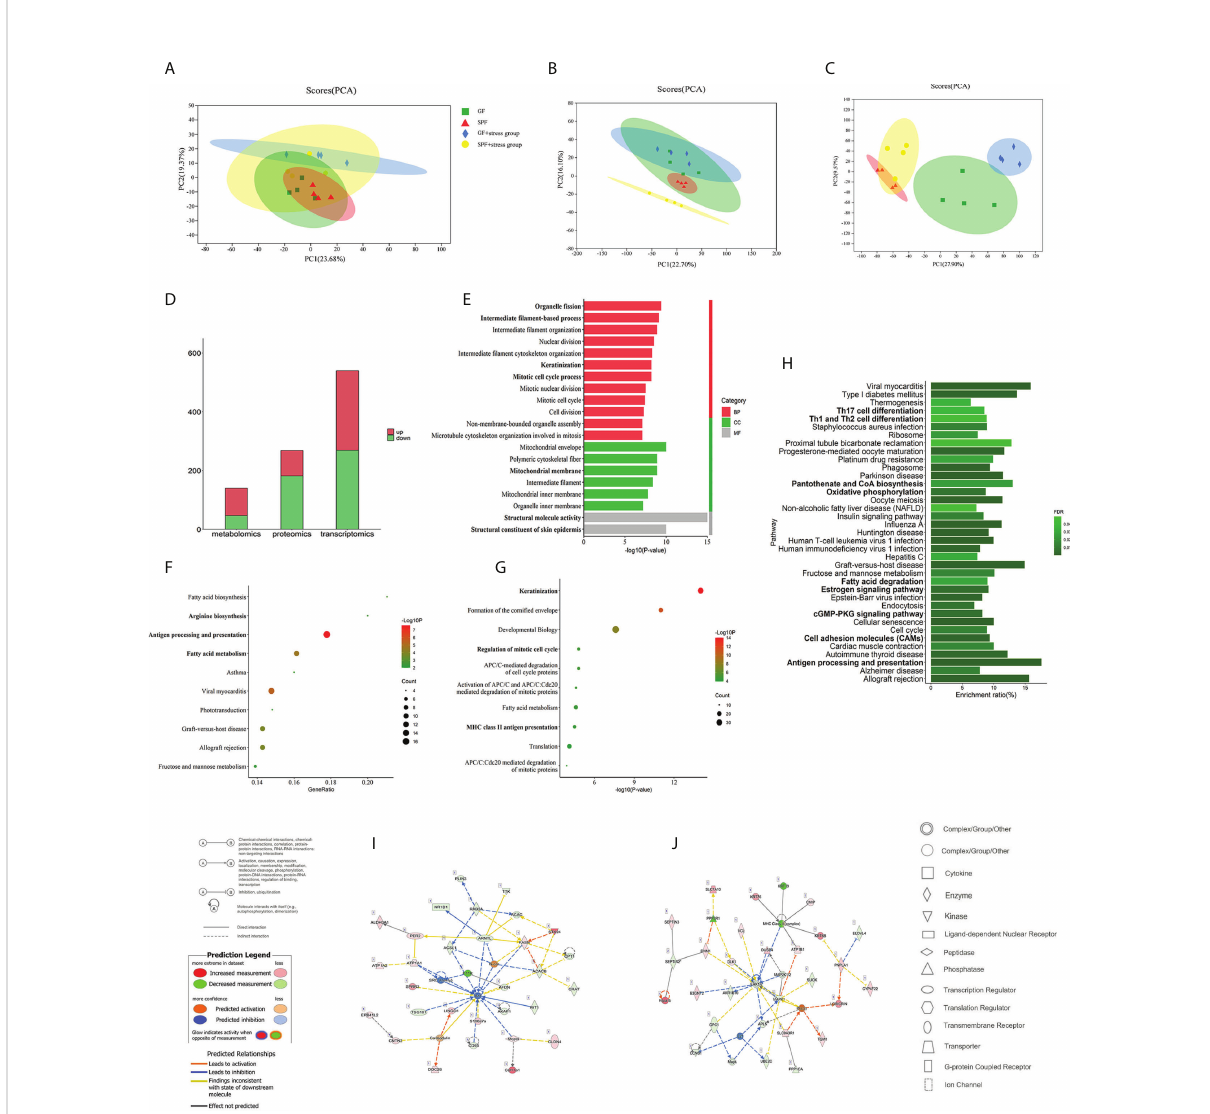
FIGURE 3 Multi-omics analysis reveals that microbiota can regulate oral homeostasis. (A – C) PCA of the transcriptomics, proteomics, and metabolomics of the tongue in SPF and GF mice. (D) Histogram showing the number of differentially expressed molecules in the tongues of SPF and GF mice during multi-omics analysis. (E – G) GO/KEGG/Reactome enrichment analysis of integrated transcriptomics and proteomics of the tongue in SPF and GF mice. (H) KEGG pathway enrichment analysis of multi-omics of the tongue in SPF and GF mice. (I, J) IPA of multi-omics of the tongue in SPF and GF mice. The bold fonts represent the molecules of particular interest in the enrichment pathway. PCA, Principal Component Analysis; IPA, Ingenuity Pathway Analysis; GO, Gene Ontology; KEGG, Kyoto Encyclopedia of Genes and